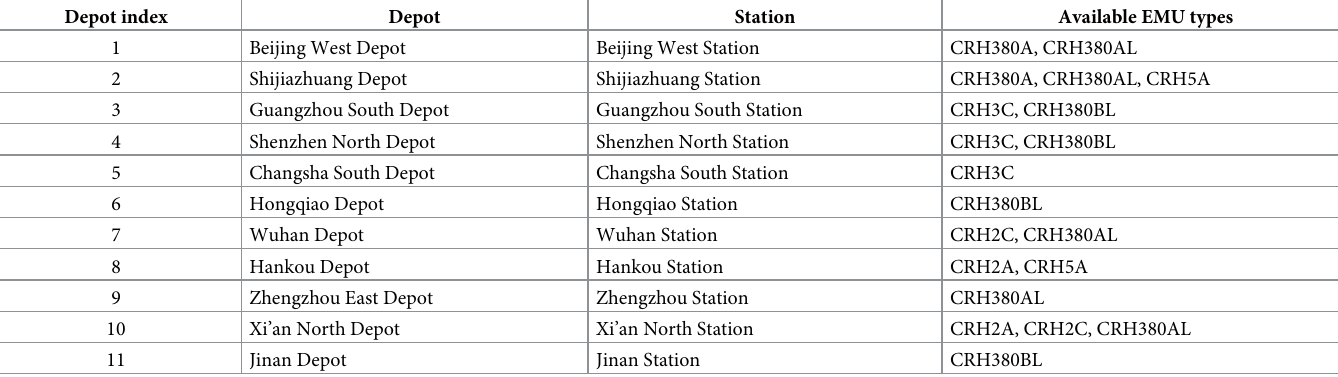
Table 10. Real-world high-speed rail depots and services at high-speed rail stations. Depot index Depot